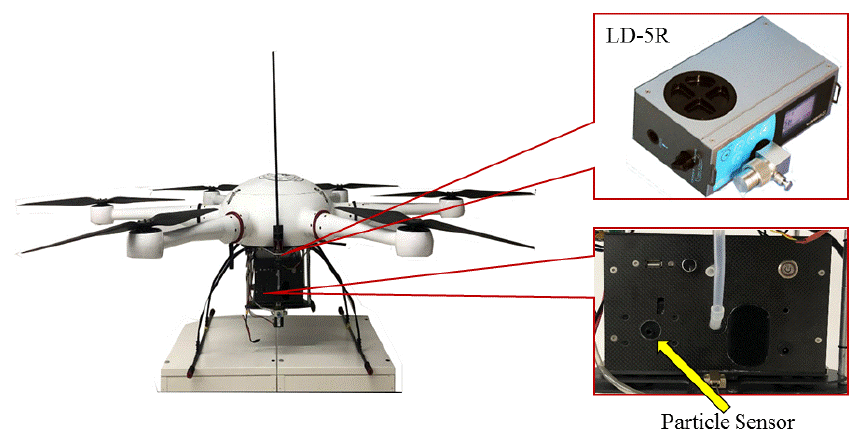
Figure 2. Self ‐ developed PM detector and commercial PM device (LD ‐ 5R, SIBATA, Kyoto, Japan) on an UAV deploying in aerial monitoring a textile dyeing industrial park in Shaoxing, Zhejiang province.